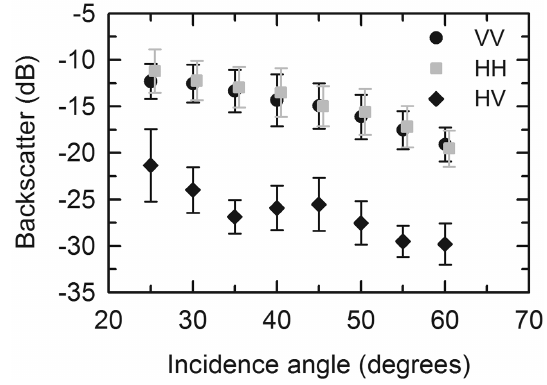
Figure 6. VV, HH and HV polarisation backscatter versus incidence angle, for the bare ice adjacent to melt ponds on level first-year sea ice. Markers for HH are offset by + 0.5 ◦ to aid in differentiating them from VV. Error bars represent standard deviation.